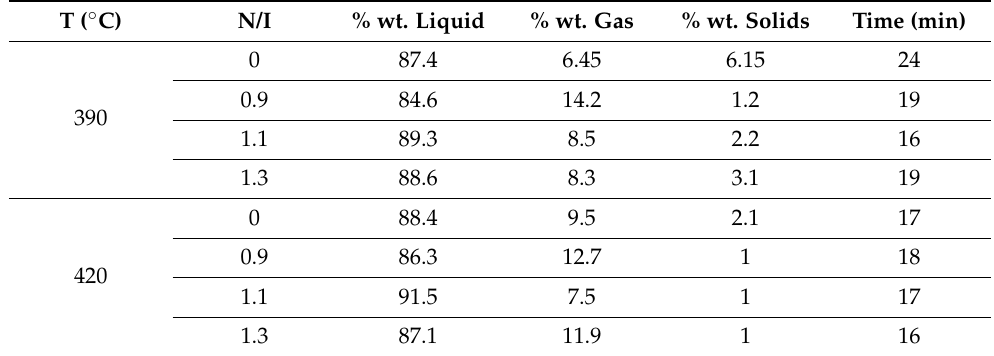
Table 4. Yields of styrene and other main components recovered in the liquid fraction in the